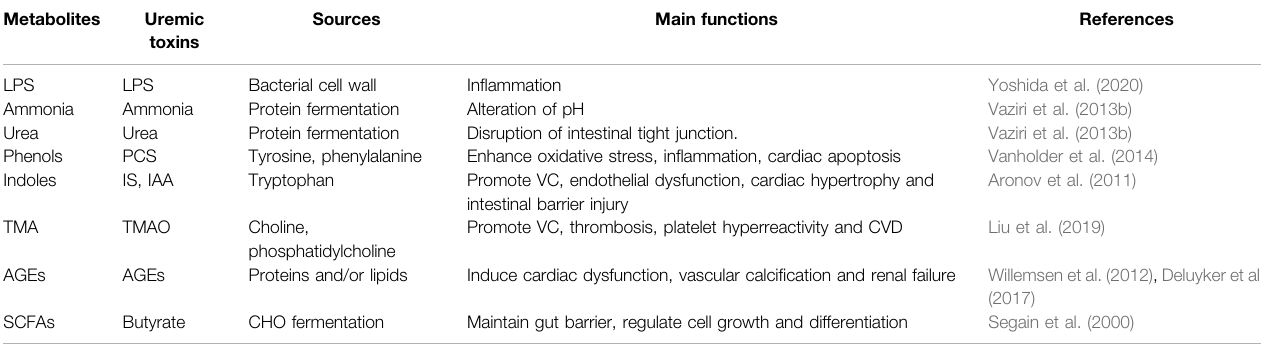
TABLE 2 | The metabolites of gut